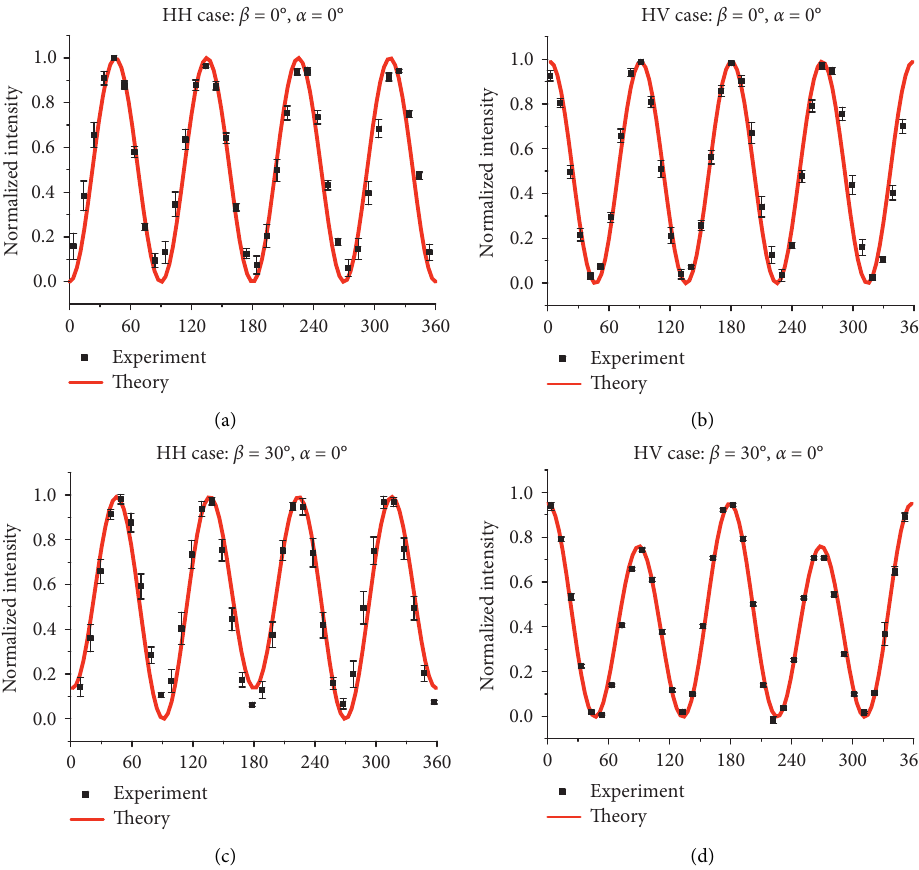
Figure 17: Comparison of experimental results (black solid points) and theoretical results (red solid line) under different geometrical configurations. (a) HH case: β � 0 ° , α � 0 ° . (b) HV case: β � 0 ° , α � 0 ° . (c) HH case: β � 30 ° , α � 0 ° . (d) HV case: β � 30 ° , α � 0 ° .